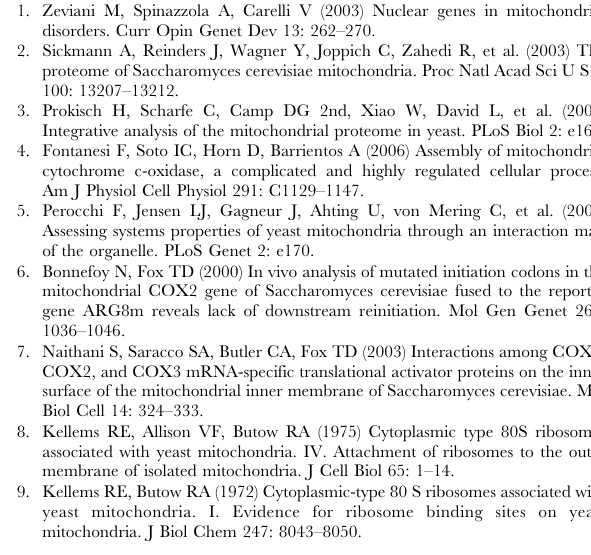
the Figure S2. The nucleus is stained in blue. Table S1 MLR properties of the mRNAs coding for mitochon- drial products. The genes are grouped in functional modules following the work by Steinmetz group (Perocchi F, Jensen LJ, Gagneur J, Ahting U, von Mering C, et al. (2006). PLoS Genet 2: e170). Four MLR classes of RNA are distinguished by different colours. Class I and class II are mRNAs whose statistical analyses (SAM q values) indicate an asymmetrical localization. This mito- chondrial localization is dependent or independent of the mRNA binding protein Puf3p, respectively. Class III corresponds to mRNAs translated on cytoplasmically-free ribosomes and class IV are mRNAs encoded in the mitochondrial genome. The MLR values (% of Mitochondrial Localization of mRNA) are repre- sented for the wild type cell in standard growth conditions or with either cycloheximide or puromycin. The mutant strain D puf3 has also been analyzed. The decision whether a gene has prokaryotic homologue is from SGD database. Puf3p binding site is from the data of (Foat BC, Houshmandi SS, Olivas WM, Bussemaker HJ (2005) Proc Natl Acad Sci USA 102: 17675–17680) and (Gerber AP, Herschlag D, Brown PO (2004) PLoS Biol 2: E79). Puf3p